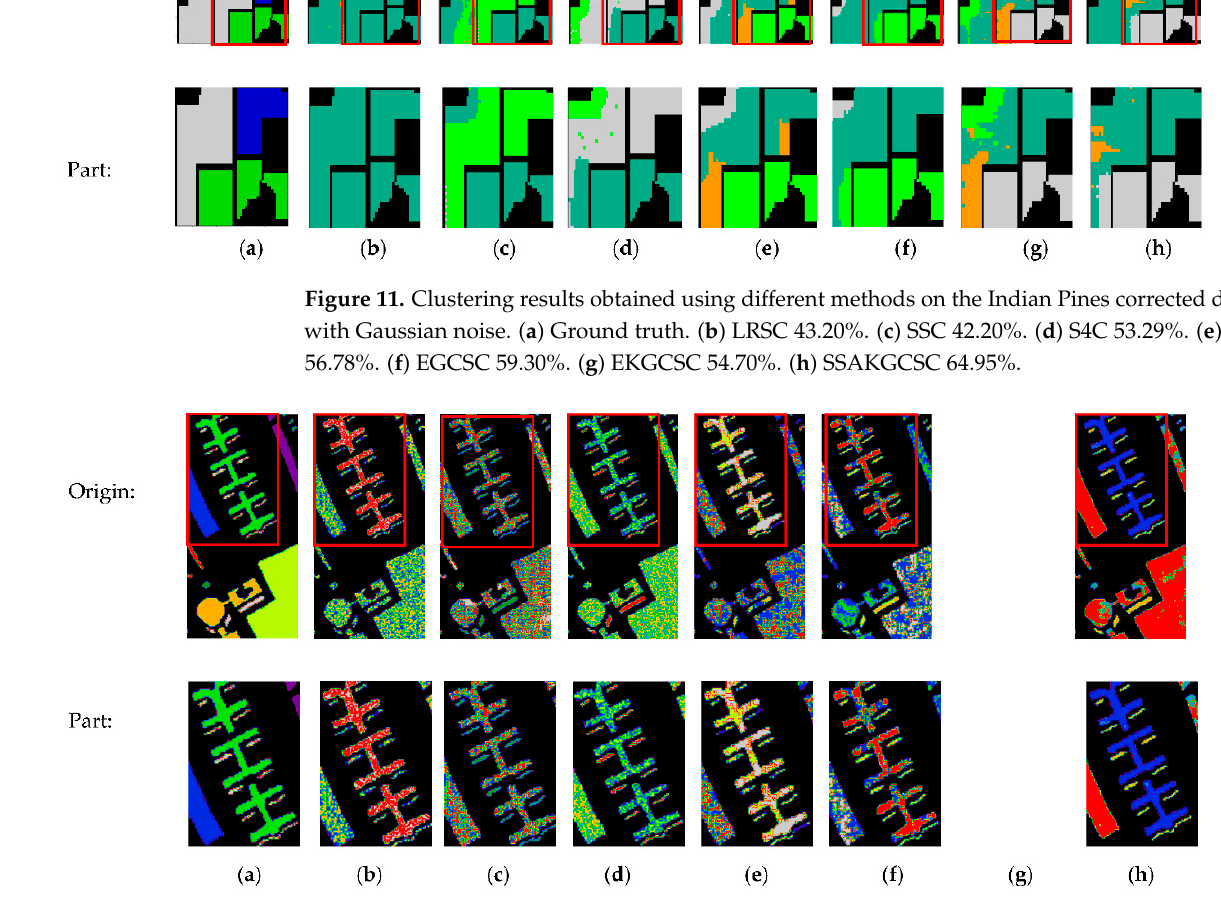
Figure 12. Clustering results obtained using different methods on the Pavia University data set with Gaussian noise. ( a ) Ground truth. ( b ) LRSC 36.90%. ( c ) SSC 36.79%. ( d ) S4C 42.51%. ( e ) EDSC 46.97%. ( f ) EGCSC 51.19%. ( g ) EKGCSC. ( h ) SSAKGCSC 67.34%.